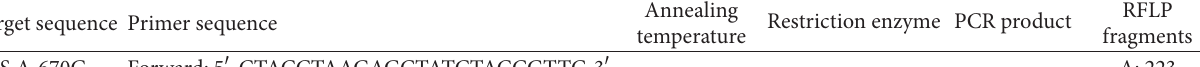
Table 1: The primer sequences, annealing temperature, restriction enzymes, and fragments size of FAS and FASL polymorphisms. Target sequence Primer sequence